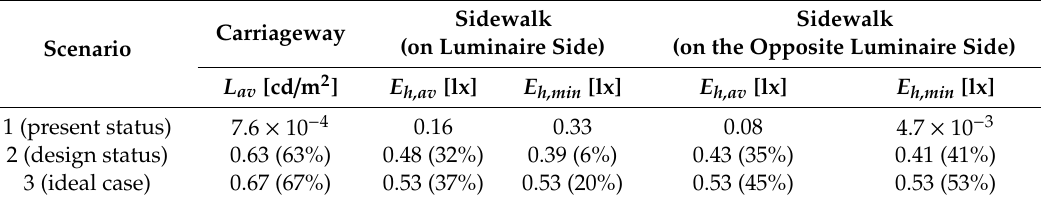
Table 11. Comparison of the coe ffi cient of determination R 2 in the three scenarios (between brackets the percentage increments of R 2 with respect to the Scenario 1 is